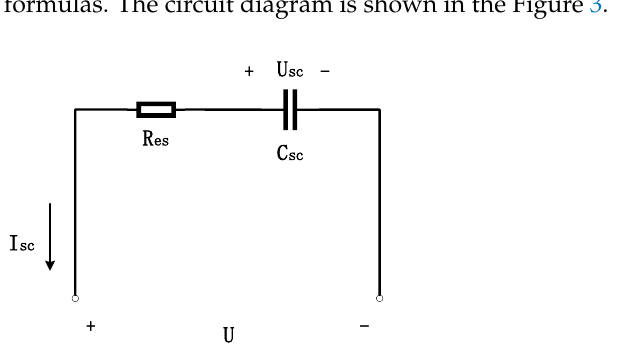
Figure 3. Supercapacitor RC Equivalent Circuit.